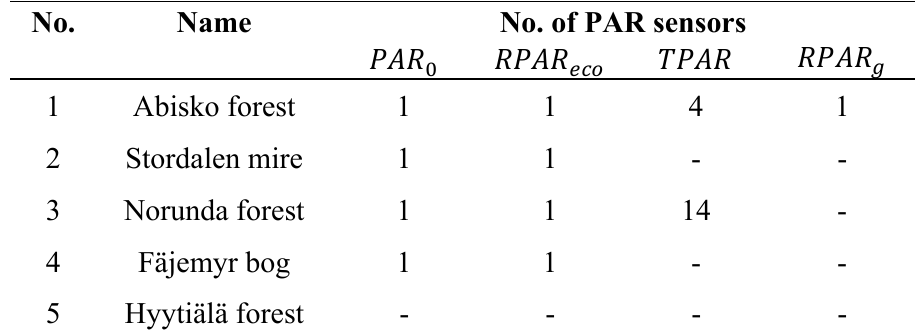
Table 4. Currently installed sensors for estimation of PAR fluxes. Abbreviations of PAR fluxes are given in the